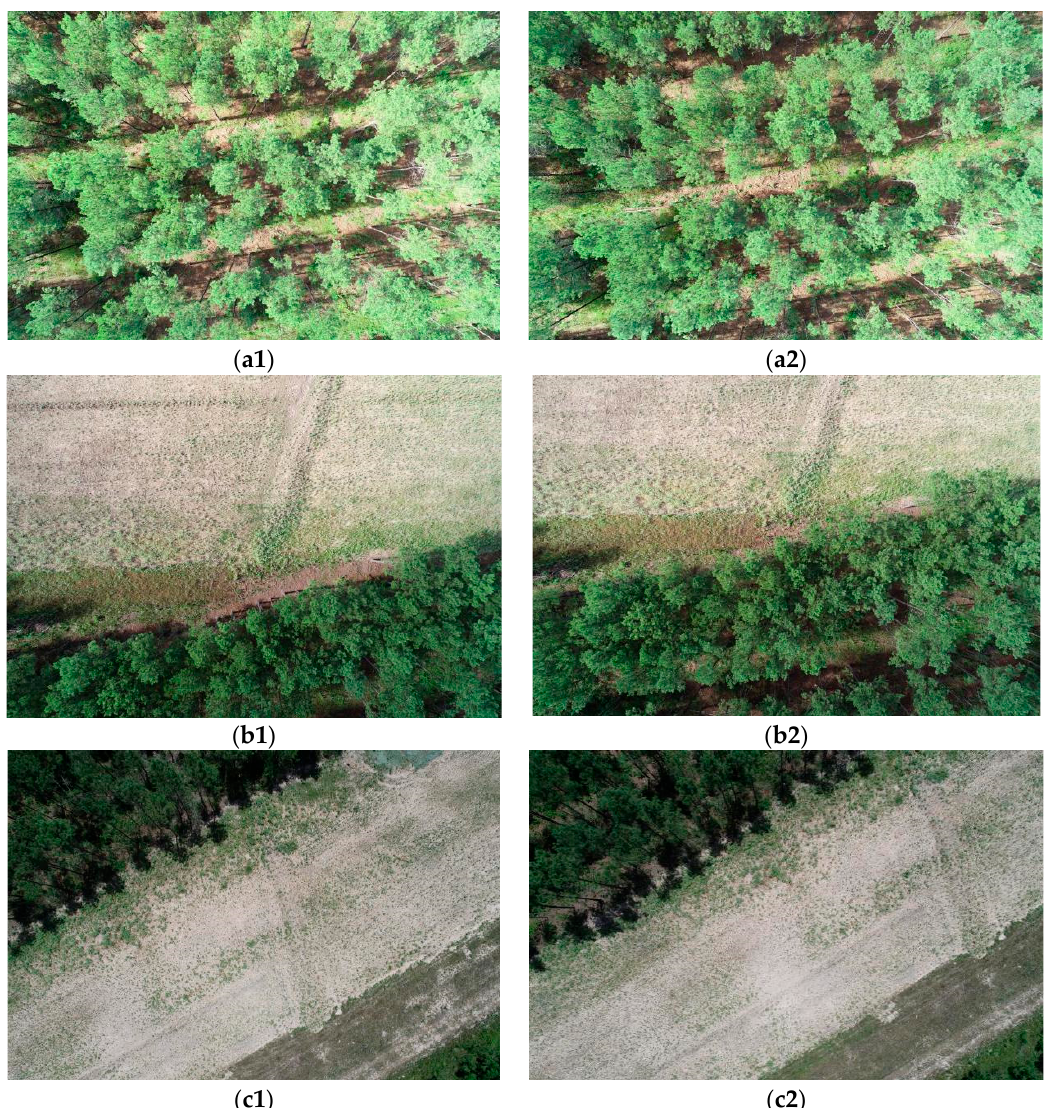
Figure 2. Three image pairs represent the forest core, forest edge, and forest road. ( a1 ) Forest core left image. ( a2 ) Forest core right image. ( b1 ) Forest edge left image. ( b2 ) Forest edge right image. ( c1 ) Forest road left image. ( c2 ) Forest road right image.